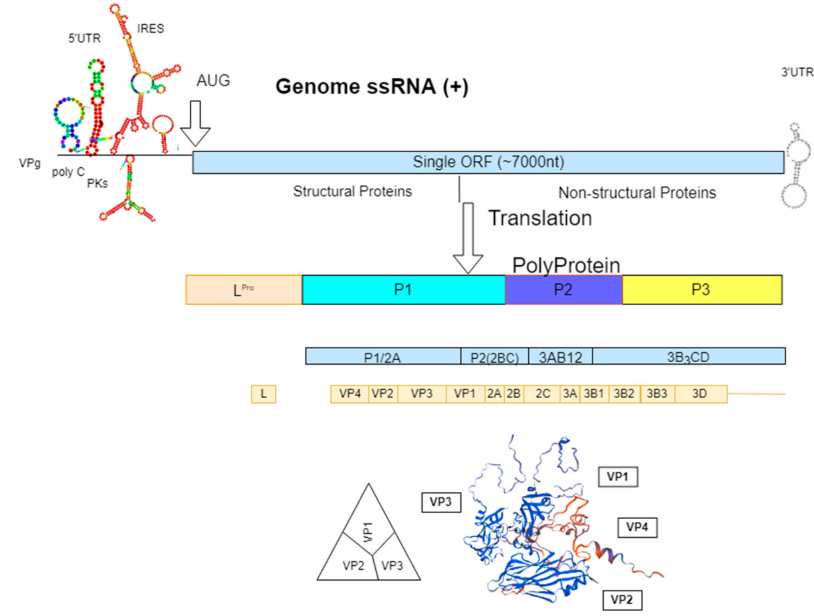
Figure 1. Schematic drawing showing the genome organization and structure of foot-and-mouth disease virus (FMDV), displaying structural and non-structural proteins. Nucleotide sequence of virus serotype O (IND228 / 14) was used for RNA secondary structure folding using RNAfold webserver (http: // rna.tbi.univie.ac.at) and structural protein refolding using Swiss Model (https: //